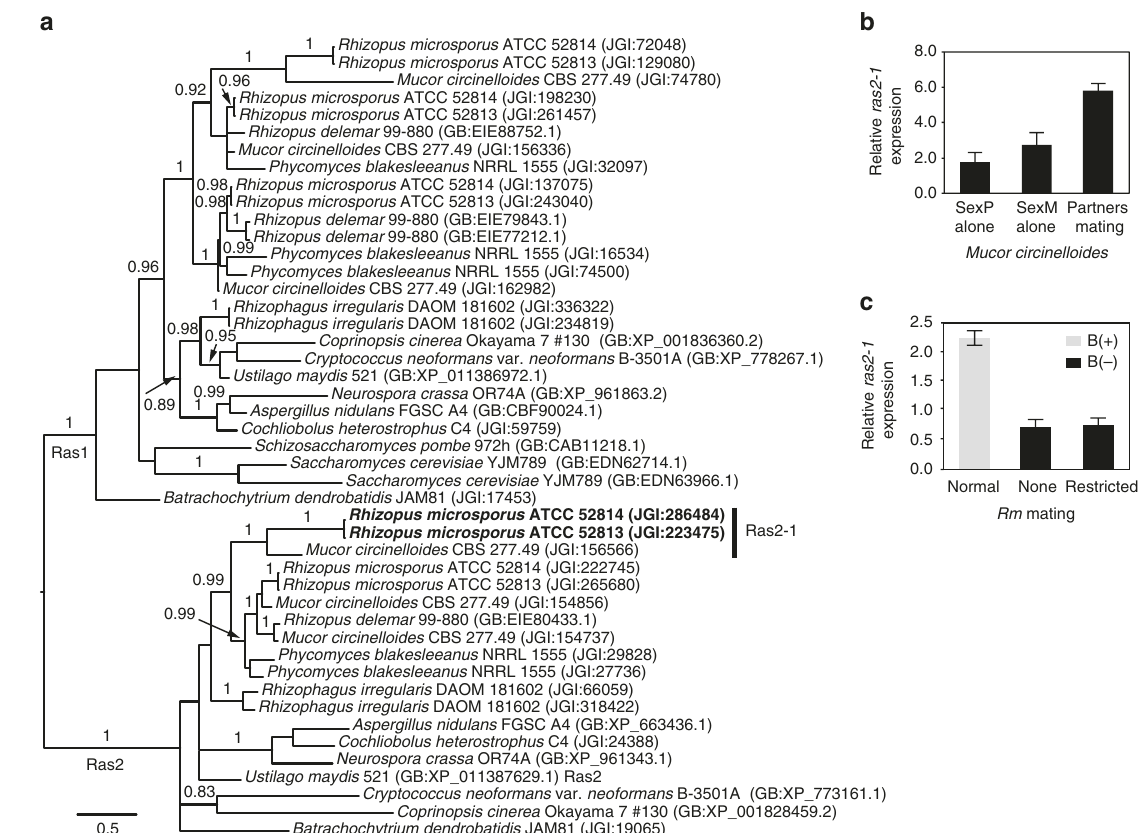
Fig. 4 Ras proteins in Mucoromycotina. a Bayesian phylogeny of proteins in the Ras1 and Ras2 ortholog groups. Protein identi fi ers include species and strain designation, as well as GenBank accession number or JGI protein ID. The Rm ras2 genes DE due to endobacteria and mating are in boldface. Posterior probability values are displayed above branches. The alignment is included in Supplementary Data 5. b Expression levels of ras2-1 in strains of Mucor circinelloides ATCC 1216b sexP and CBS 277.49 sexM measured in mates grown alone before the onset of asexual sporulation and during a mating interaction. Three replicate cultures were examined per condition. Error bars represent s.e.m.. c Expression levels of the ras2-1 gene during mating between Rm ATCC 52813 and ATCC 52811 exhibiting normal mating, restricted mating, and total loss of mating. Each condition had three biological replicates. B(+), endobacteria present; B( − ), endobacteria absent; error bars represent